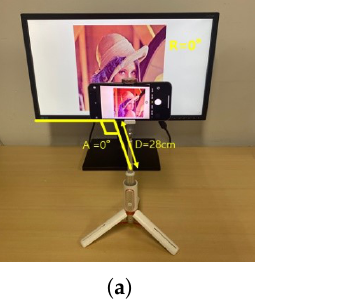
Figure 18. Experimental setup according to display-camera rotation. ( a ) R = 0 ◦ . ( b ) R = − 60 ◦ .